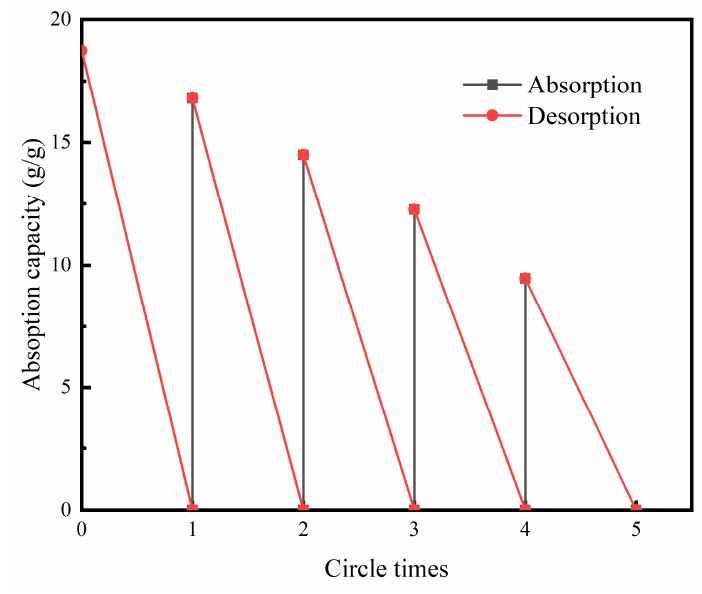
Figure 9. Absorption–desorption recyclability of PDMS/GA for n-hexane. Compared with the above research, the adsorption capacity of PDMS/GA on oil-water mixture was